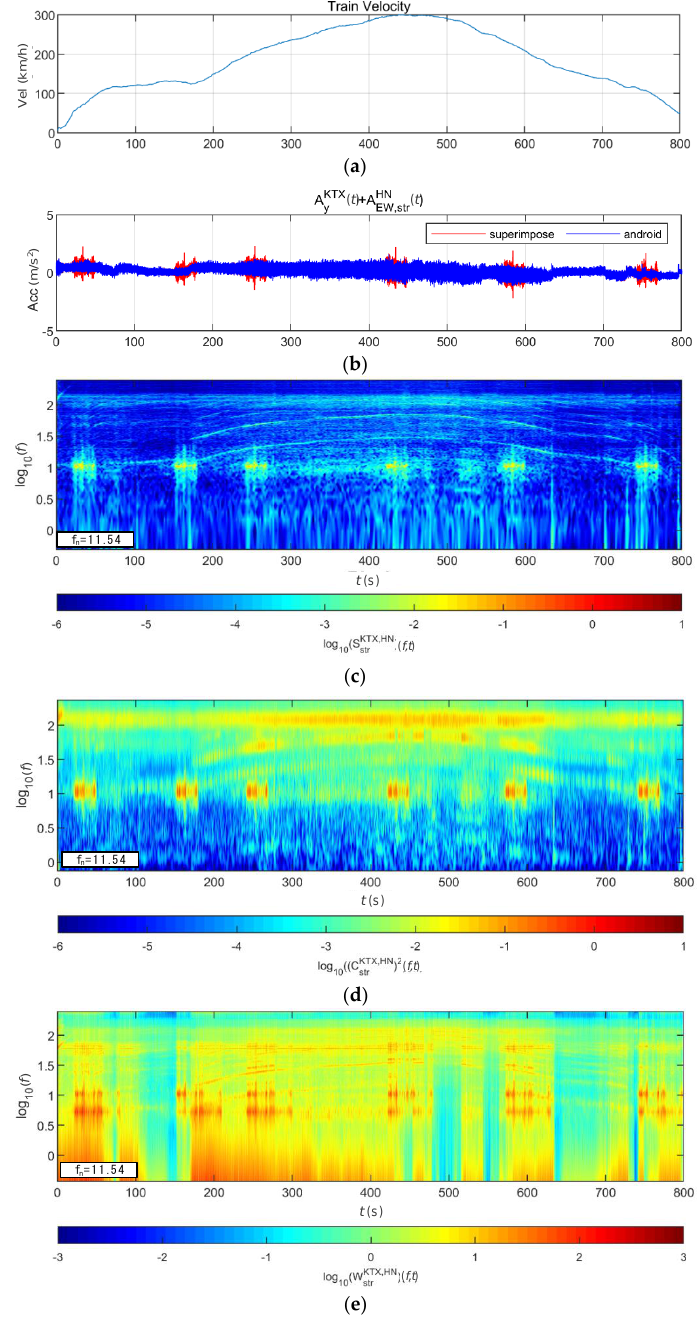
Figure 32. Combination of train data with BR2 bridge-response data from the Hachinohe earthquake (scaled to 1000-year return period): ( a ) velocity; ( b ) lateral acceleration time series; ( c ) STFT; ( d ) WT; ( e ) WVD.